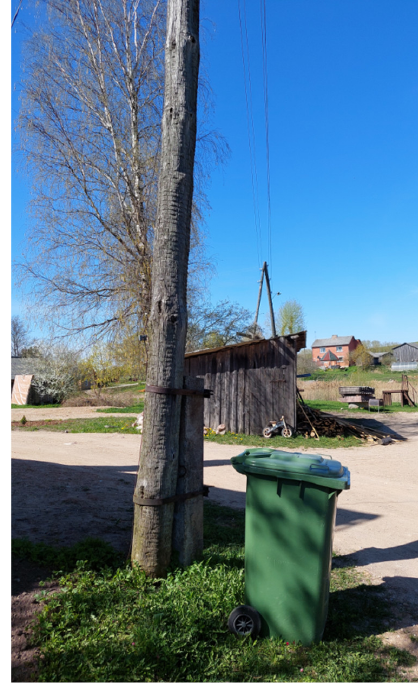
Figure 23. Example of violation in protection zone.